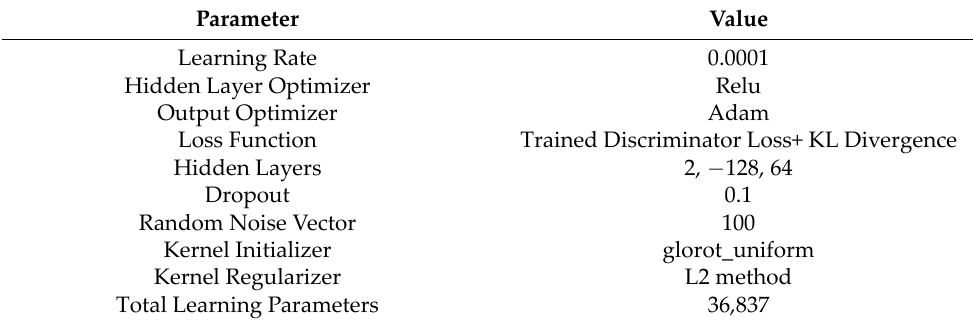
Table 4. K‑CGAN Generator Neural Network Hyperparameter Settings.